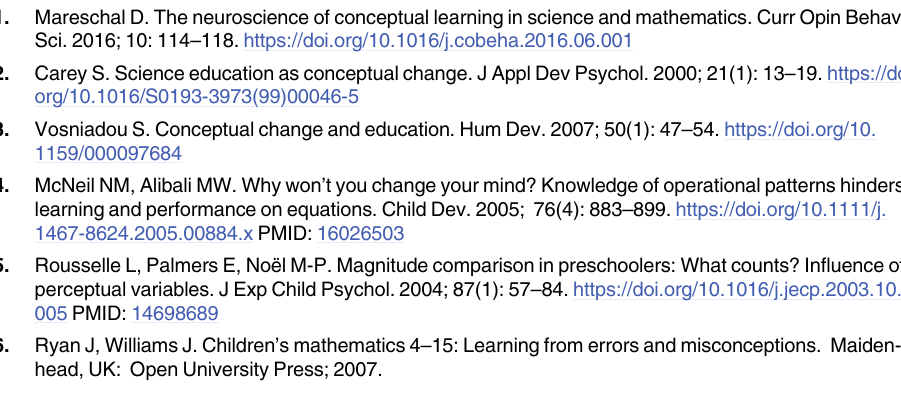
S1 Fig. Example problem-sets in (a) science and (b) maths. S2 Fig. Histogram of mean accuracy in the 96 science and maths misconception problems. The range of mean accuracy observed suggests that although the mean overall Misconception